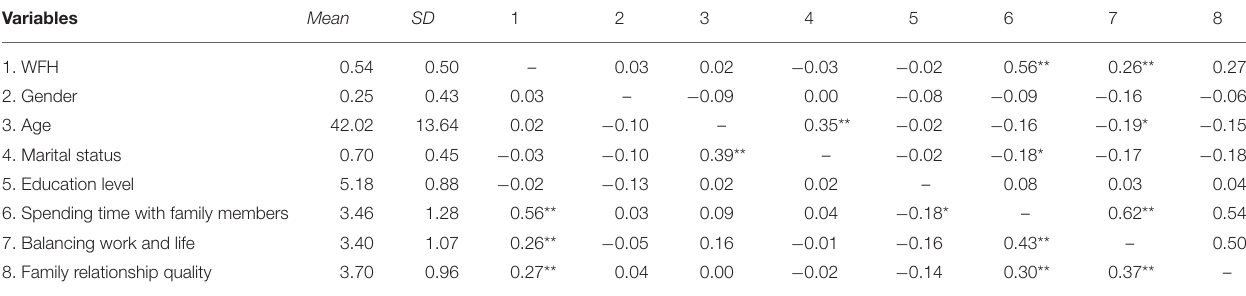
TABLE 2 | Mean, standard deviations, and correlations of all study variables.